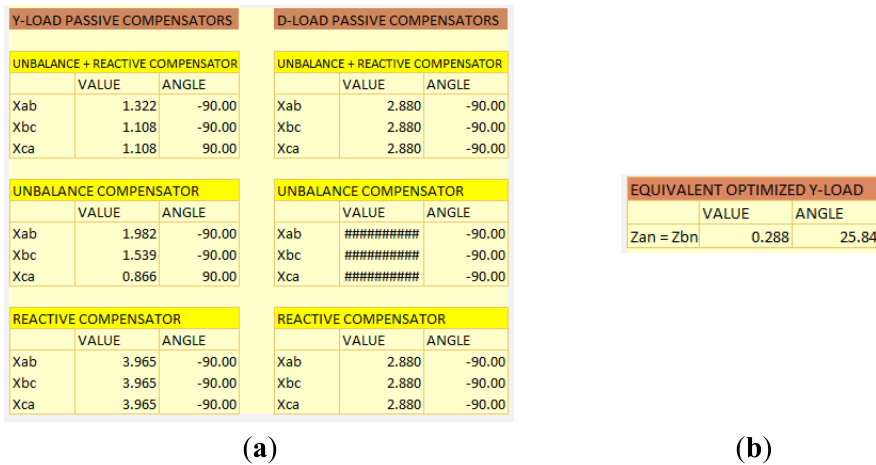
Figure 8. Compensation devices and techniques: ( a ) passive compensators; ( b ) optimized wye